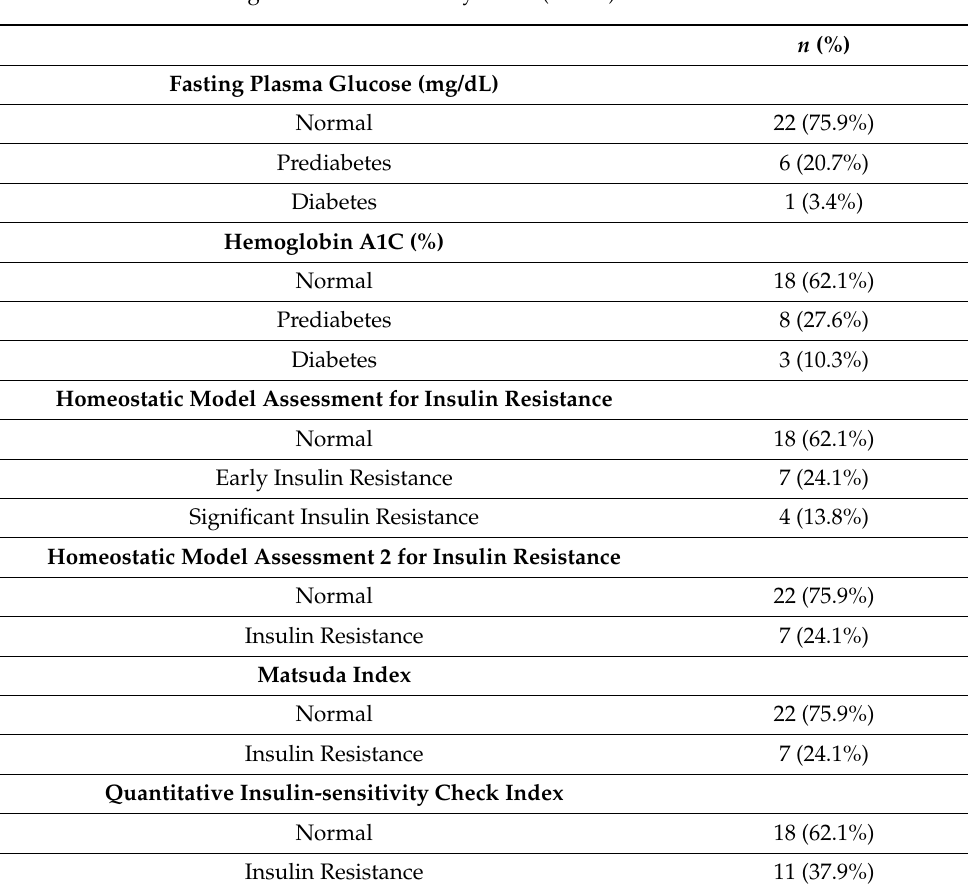
Table 3. Classification of glucose metabolism by index ( n =